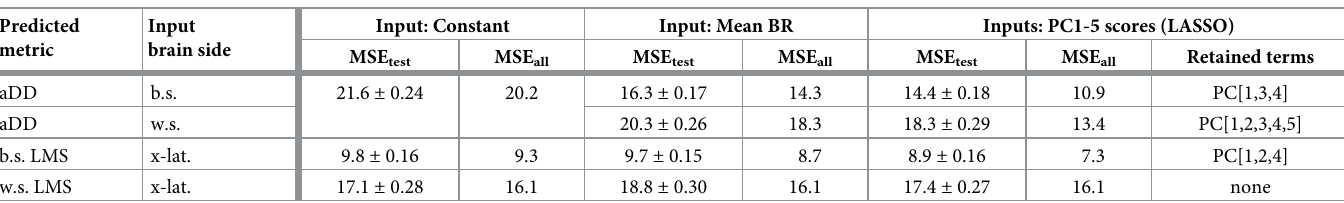
Table 3. Prediction MSEs of DTBZ-based models (PUTAMEN).